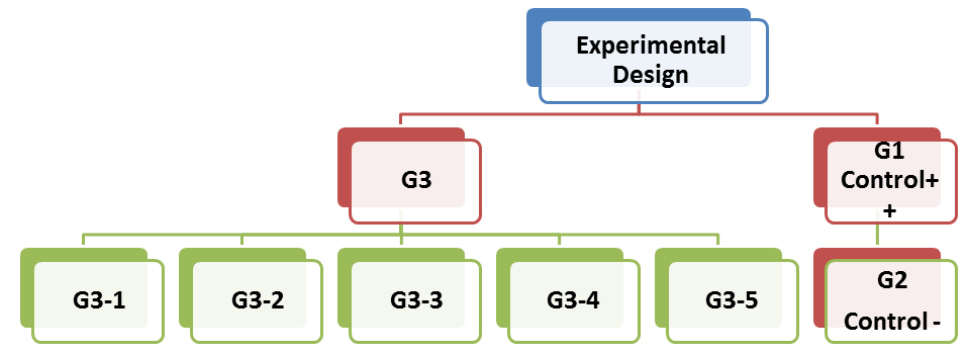
Figure 1. Treated groups in this study.